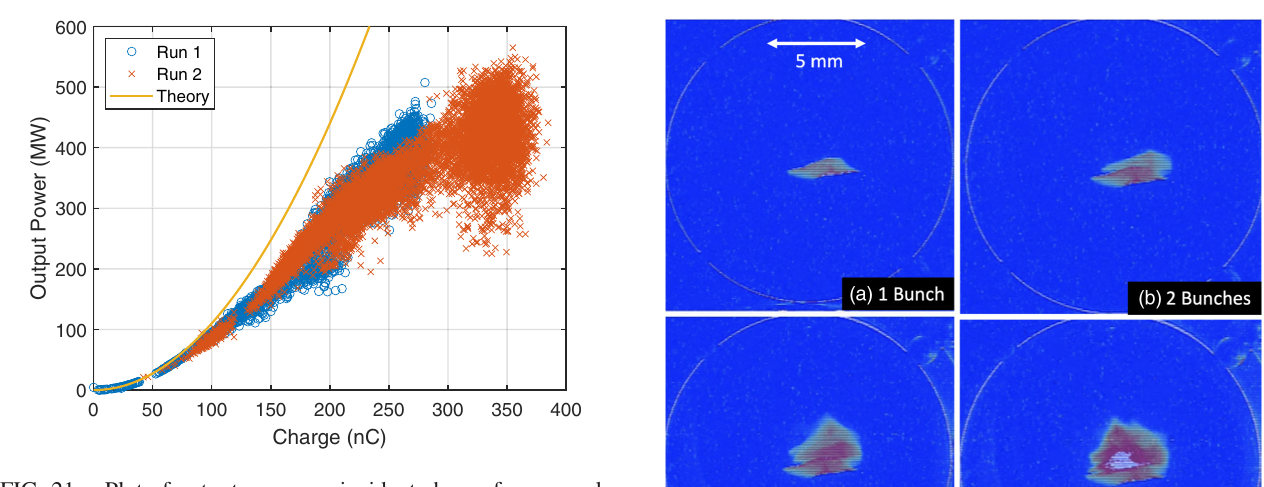
FIG. 21. Plot of output power vs incident charge for a sample of 600 experimental shots from Run 1 and Run 2 compared to theory. The deviation from theory starts to appear above 100 nC of total charge.